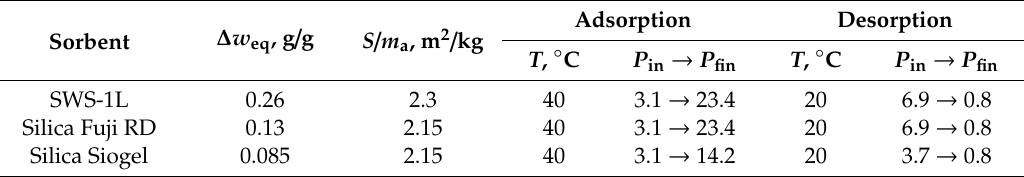
Table 7. Conditions of the dynamic